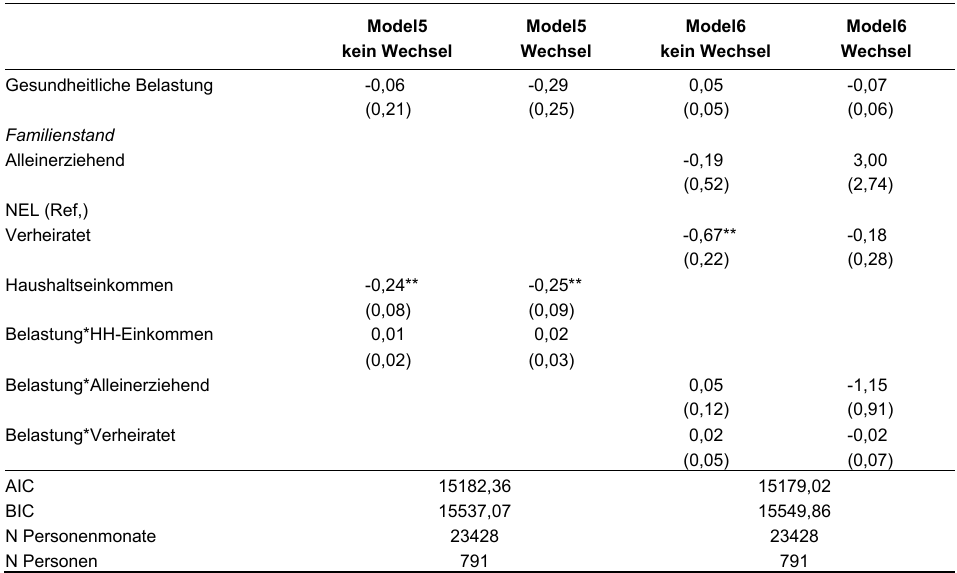
Tabelle 3 : Competing Risk-Modell mit Referenz Nichterwerbstätigkeit, mit Interaktionseffekten Model5 Model5 Model6